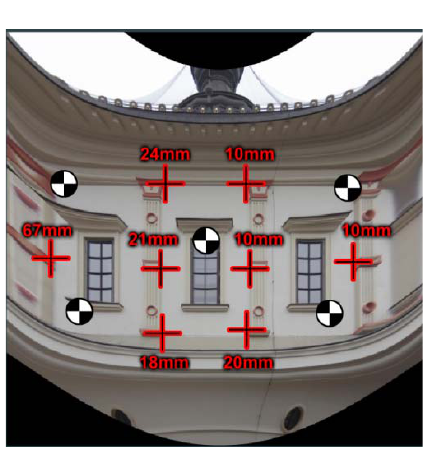
Figure 14. Measured control points, pixel size 5mm, standard deviation on control points 21mm.